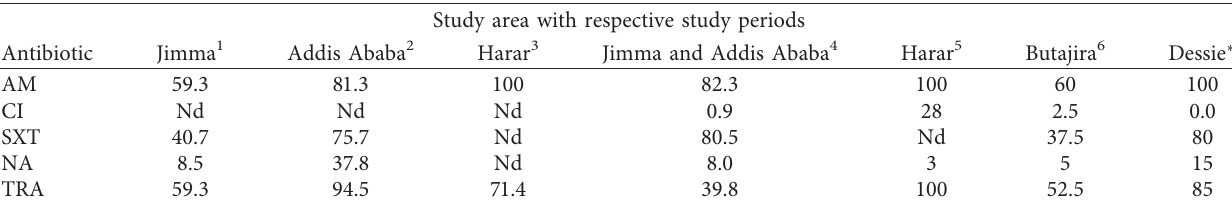
Table 5: Antimicrobial resistance patterns of Salmonella in the present study and similar other research studies in different parts of Ethiopia. Study area with respective study periods